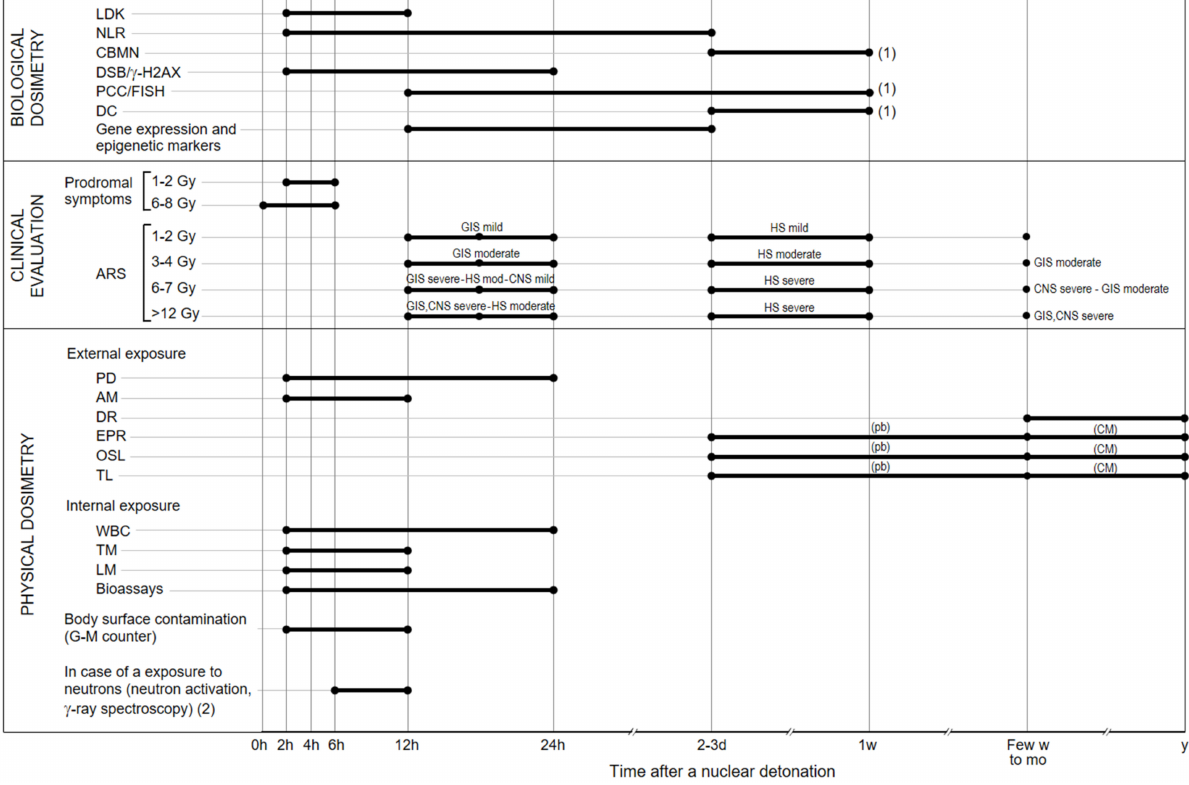
Figure 1. Stepwise dosimetry and evaluation after a nuclear detonation. (1) Results can be